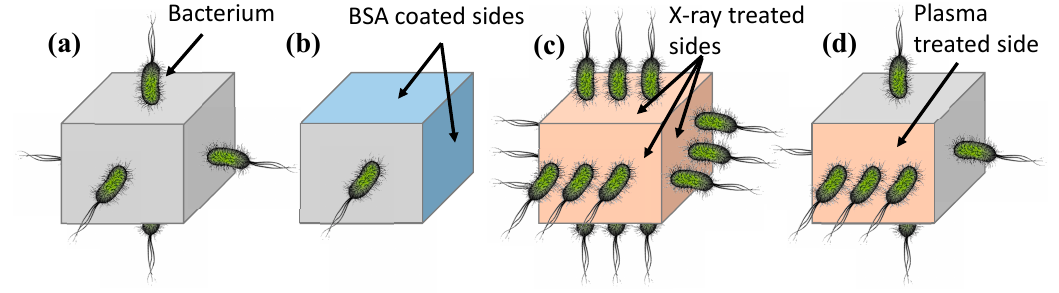
Figure 3. Schematic diagrams of bacteria-tethering. ( a ) Untreated control microstructure. ( b ) Microstructure coated on five-sides by bovine serum albumin (BSA). ( c ) X-ray irradiation treated microstructure. ( d ) Microstructure treated on one side by O 2 plasma.